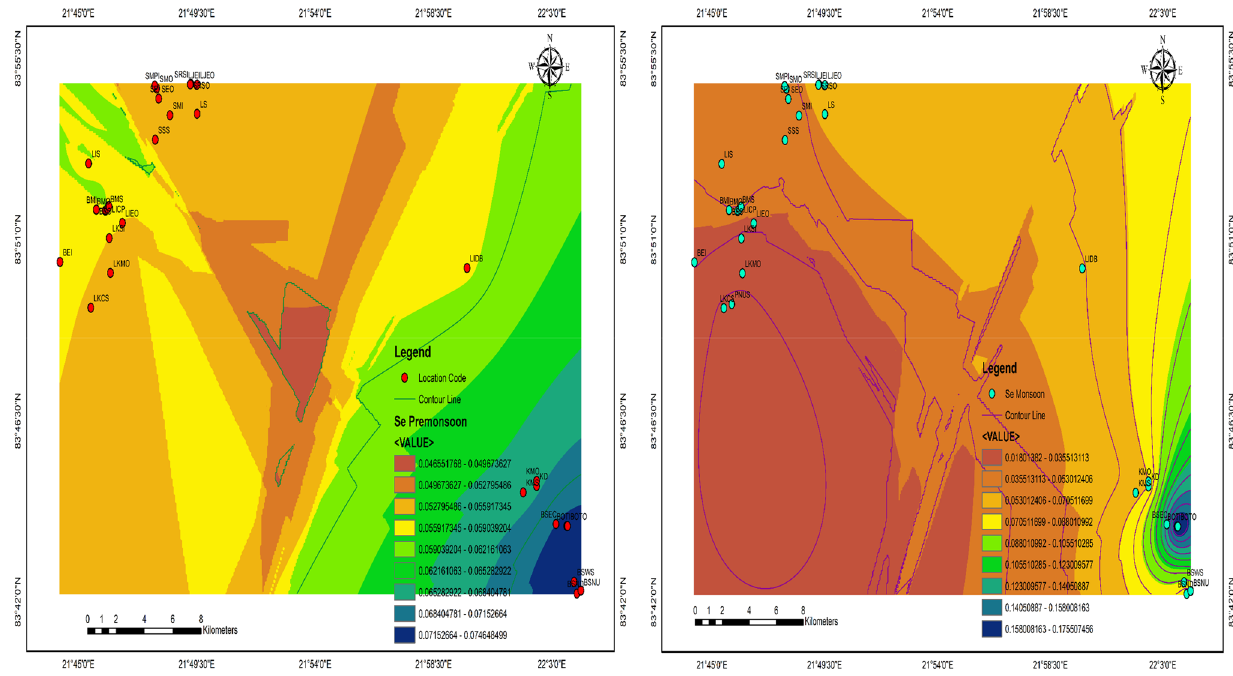
Fig. 12 Contour map for Se concentration in water samples during premonsoon and monsoon